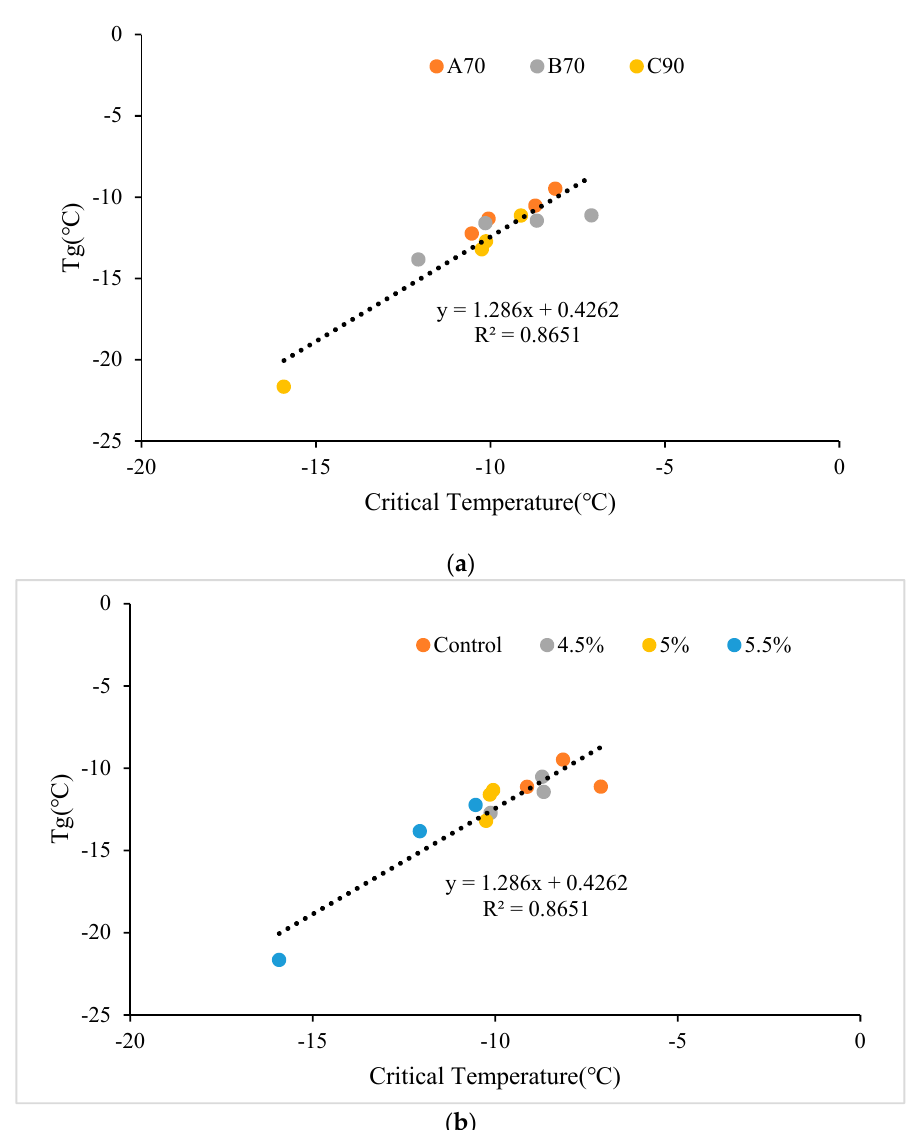
Figure 7. The relationship between critical temperature and T g ( a ) different binder sources. ( b ) different content of SBS.